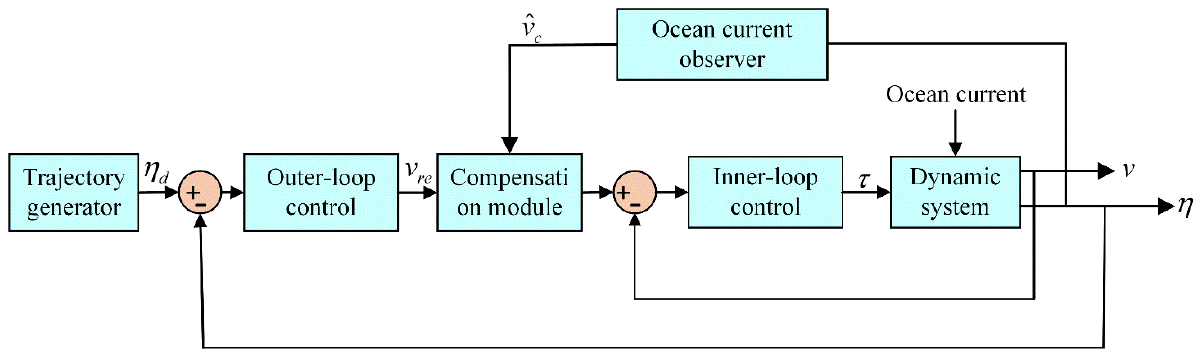
Figure 2. The logic block diagram for the double-loop SMC with an ocean current observer.